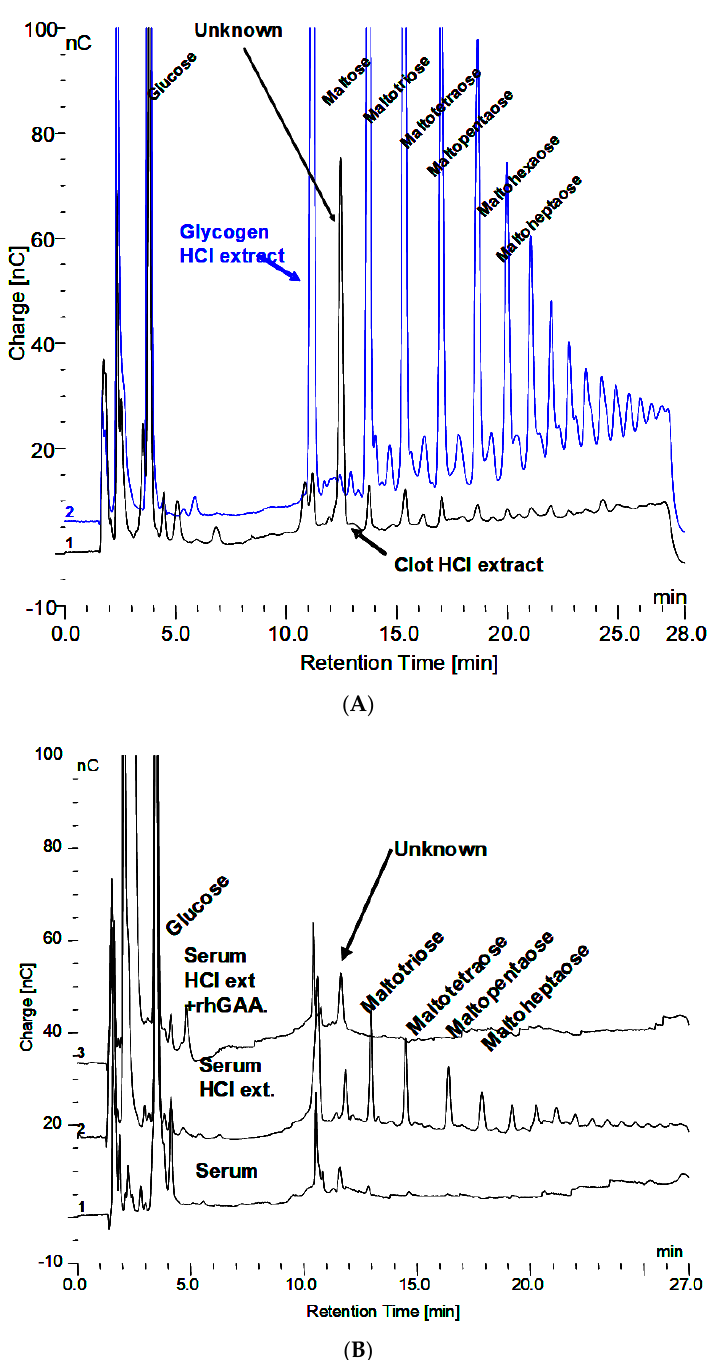
Figure 3. ( A ) Glycogen HCl extract showing maltooligosaccharides DP2-16 and clot HCl extract with array of maltooligosaccharides and the Unknown. ( B ) Serum, serum HCl extract, and serum HCl extract after rhGAA incubation.